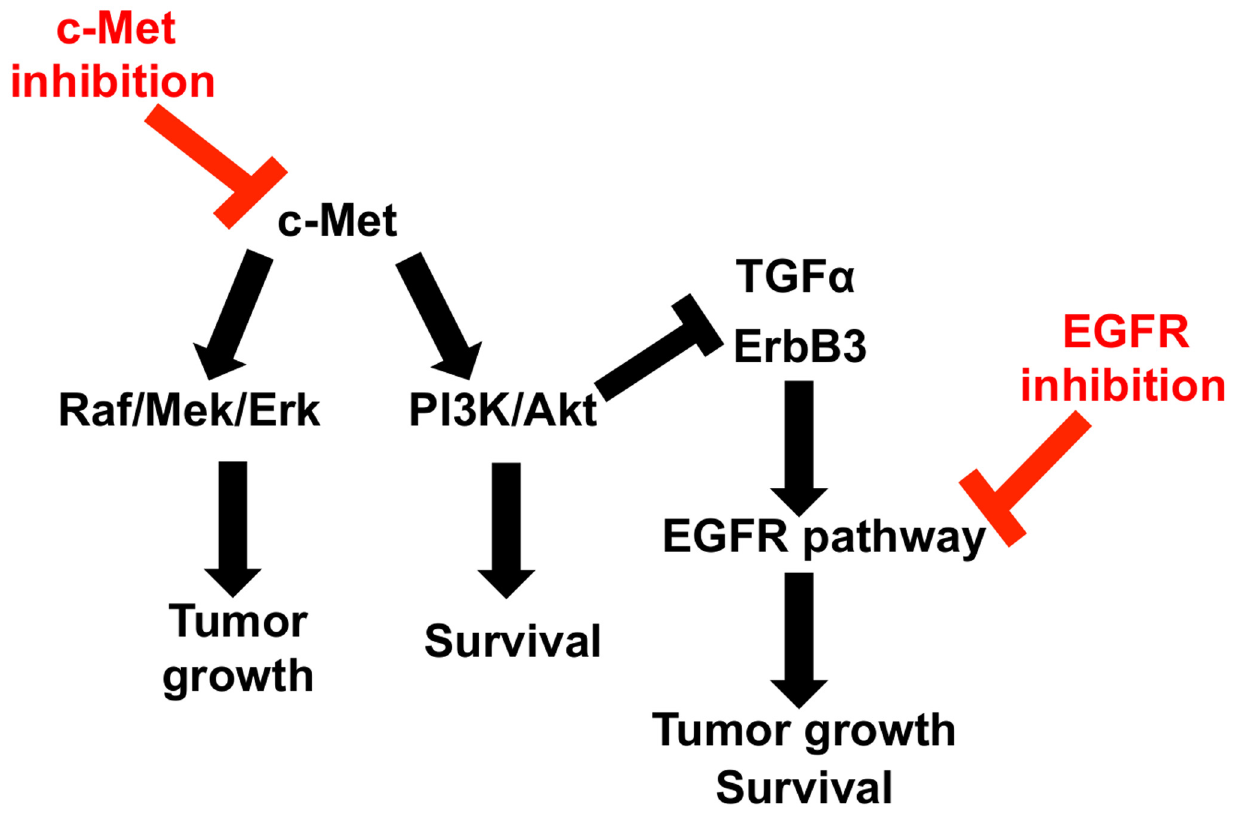
Fig 6. Schematic of c-Met and EGFR pathway crosstalk in c-Met + HCC. c-Met activates MAP kinase (Raf/Mek/Erk) and PI3K/Akt signaling to induce HCC growth and survival. The PI3K/Akt arm of the c-Met signaling pathway normally suppresses EGFR pathway members (i.e. TGF- α and ErbB3), thus suppressing EGFR pathway activity. Suppression of c-Met signaling leads to loss of PI3K/Akt activity, and thus up-regulation of TGF- α and ErbB3 members of the EGFR signaling pathway. ErbB3 can heterodimerize with ErbB1 (EGFR), forming a potent EGFR receptor. Additionally, EGFR ligand TGF- α stimulates EGFR pathway activation, leading to cancer cell growth and survival. Targeting both EGFR and c-Met suppress pathway cross talk and leads to greater suppression of tumor growth and survival.